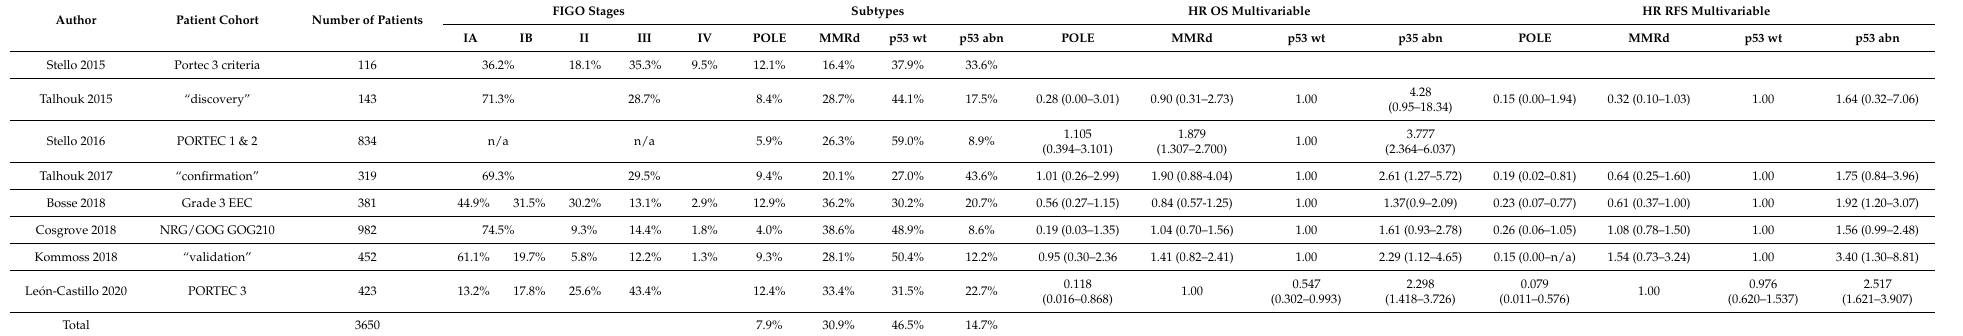
Table 3. Published trials using